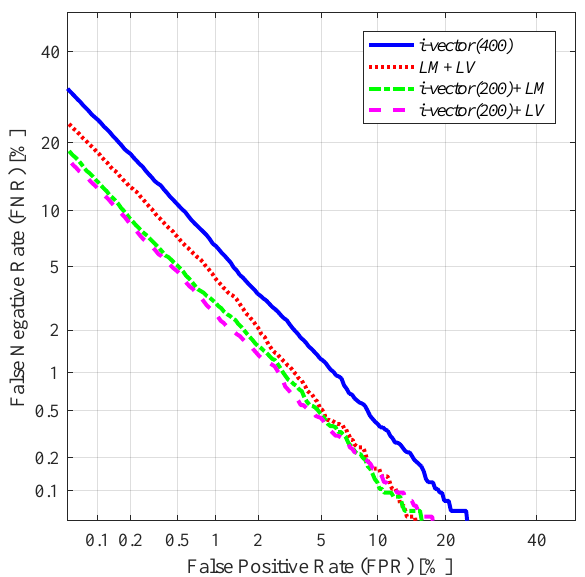
Figure 6. DET curves of the speaker verification experiments using a 400-dimensional i-vector and combinations of two features out of the 200-dimensional i-vector, latent variable mean (LM), and the log-variance of the latent variable (LV). Table 2. Comparison of results between various feature-level fusions of the conventional i-vector and mean and log-variance of the latent variable extracted from the proposed VAE. ine Class. Err. (%) EER (%) DCF08 DCF10